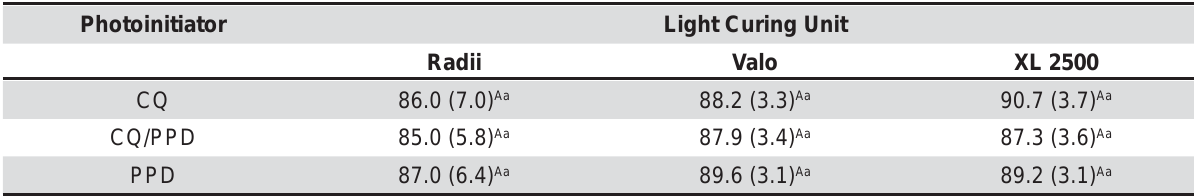
Table 6- Mean CLD value (%) and standard error (±) provided for each of the photoinitiator